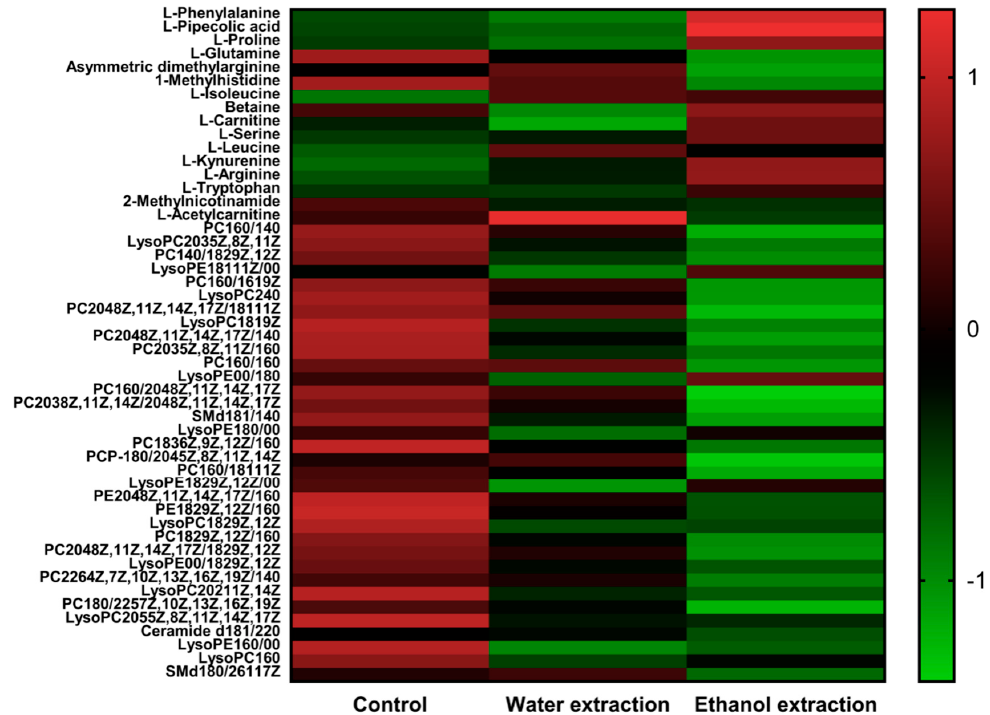
Figure 6. Serum metabolites in the control, water extract, and ethanol extract groups. The concentration of small molecule metabolites in each group of rats was measured and treatment was normalized, and the − 1 to +1 range was used to represent the contrast intensity; With reference to the ruler, the depth of the color represents the level of the content.